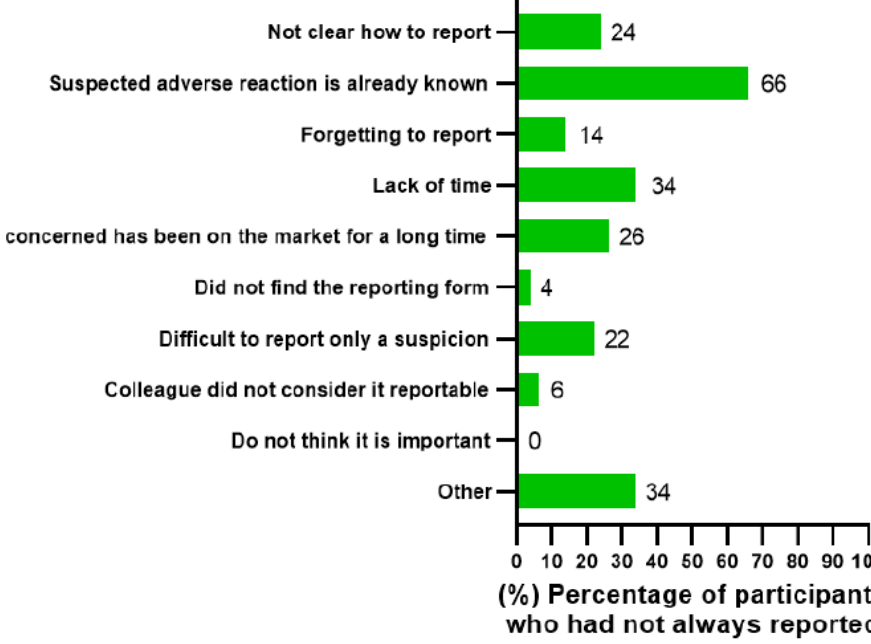
Figure 4. Reasons why healthcare professionals had not always reported suspected adverse drug reactions to the local health authority (Finnish Medicines Agency) or the marketing authorization holder, percentage (%) of HCPs.